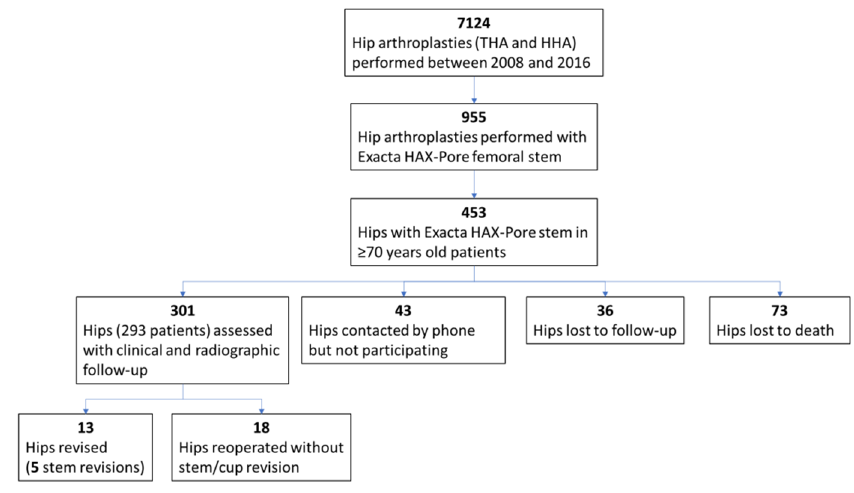
Figure 2. Study flow diagram.